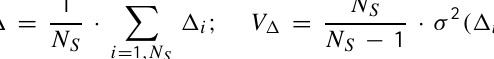
non perturbed time series. By iterating this process thou- sands of times (Monte Carlo analysis), MoCo yields an es- timate of the systematic error (the average error) and of the standard error (the standard deviation of the error) for the type of reconstruction that was simulated (Fig.